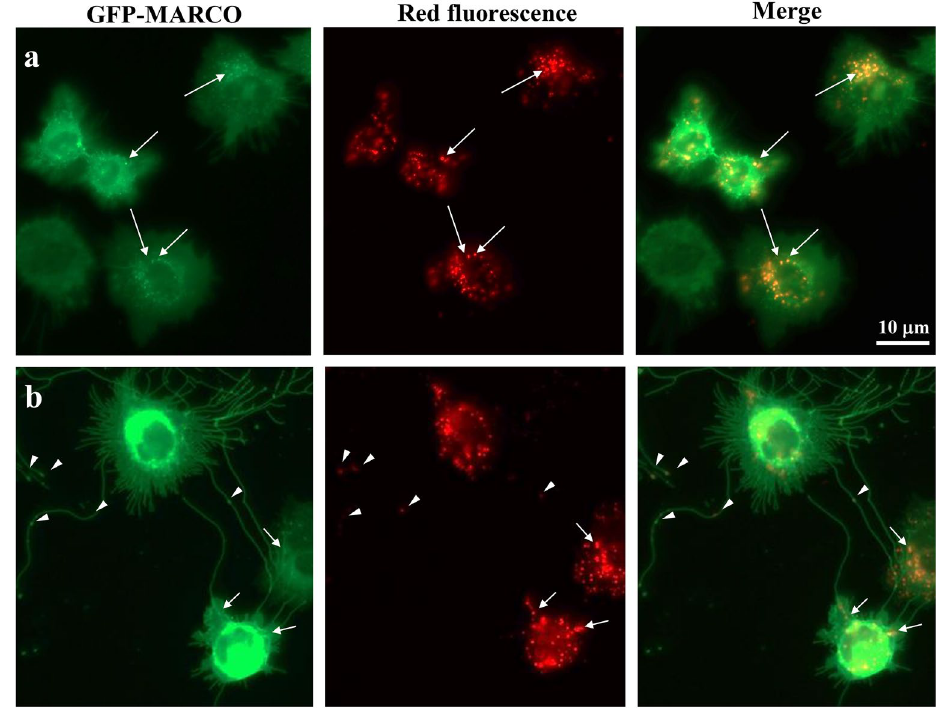
Figure 4. Localization of MARCO and red fluorescent exosomes ( a ) or 20-nm red fluorescent nanoparticles ( b ) in GFP-MARCO cells. GFP-MARCO cells were cultured with the red fluorescent exosomes ( a ) or 20-nm red fluorescent nanoparticles ( b ) for 6 h. The localization of MARCO and exosomes or 20-nm nanoparticles were examined using fluorescence